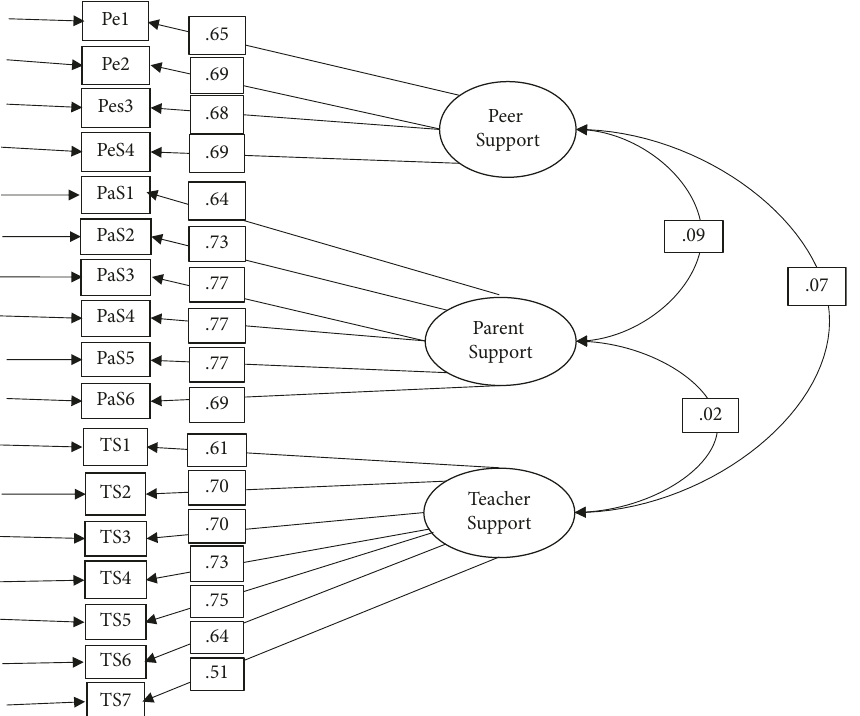
Figure 2: CFA of learning support. Note: PE � peer support; PaS � parent support; TS � teacher